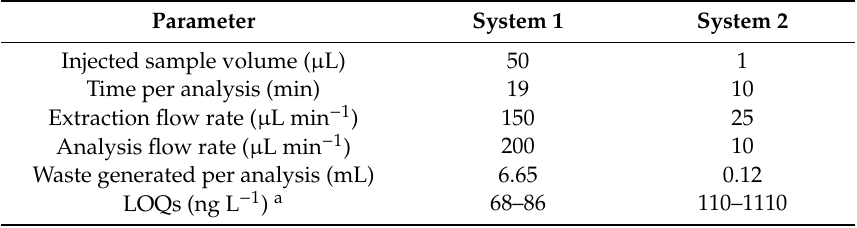
Table 2. Comparison between the main analytical characteristics of systems 1 and